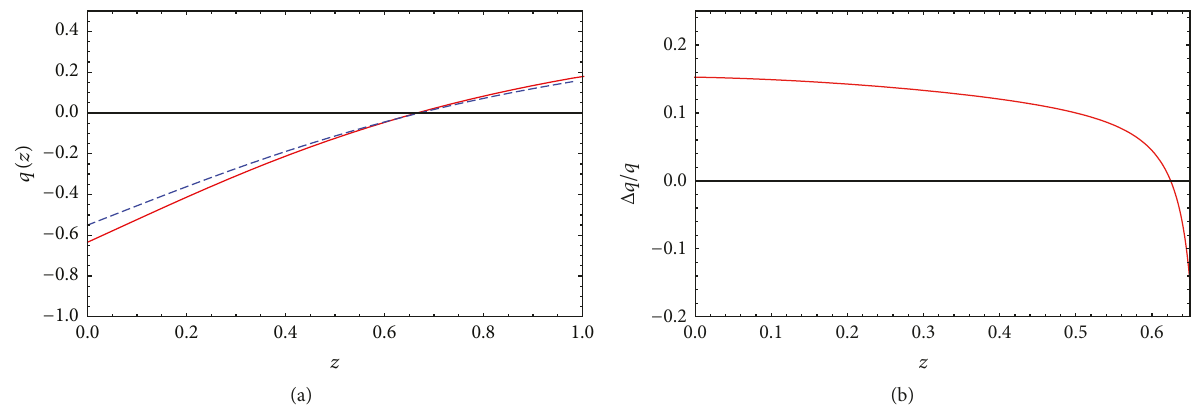
Figure 1: (a) Behaviors of the deceleration parameters for our model (red line) and for the concordance paradigm (dashed line), with indicative values Ω 𝑚,0 = 0, 3 and 𝛽 as reported in (29). (b) Variations between our model and the Λ CDM approach.